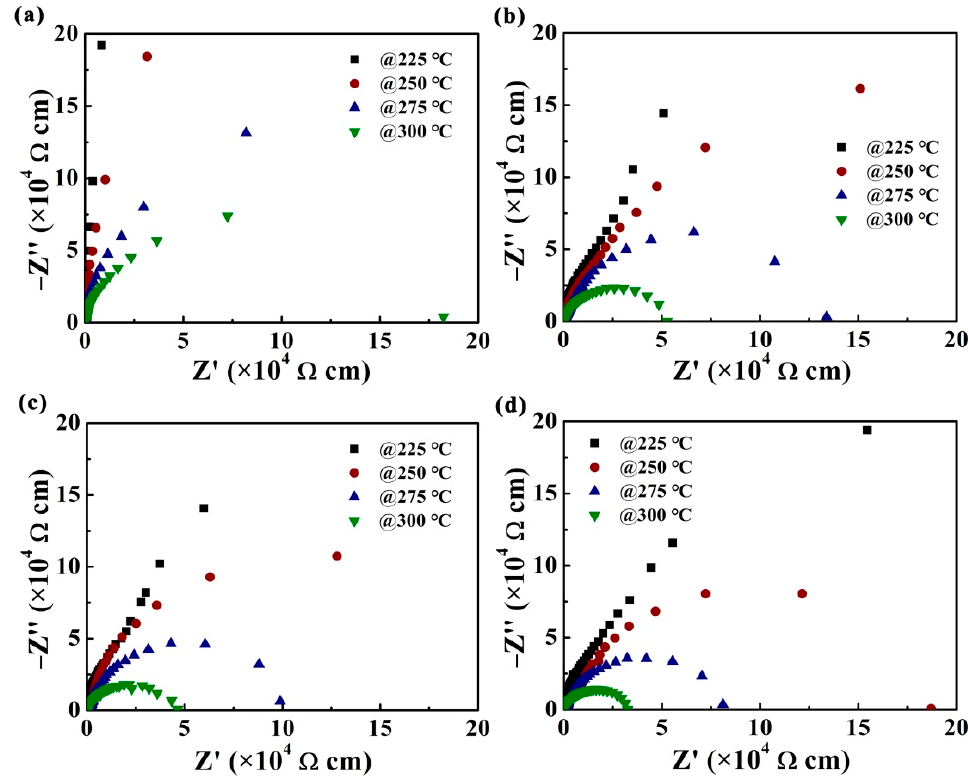
Figure 4. Nyquist diagrams of complex-plane of the CBTi-BFO films with annealing temperature of ( a ) 450, ( b ) 500, ( c ) 550, ( d ) 600 °C measured at 20 V under four measured temperatures. ( a ) 450, ( b ) 500, ( c ) 550, ( d ) 600 ◦ C measured at 20 V under four measured